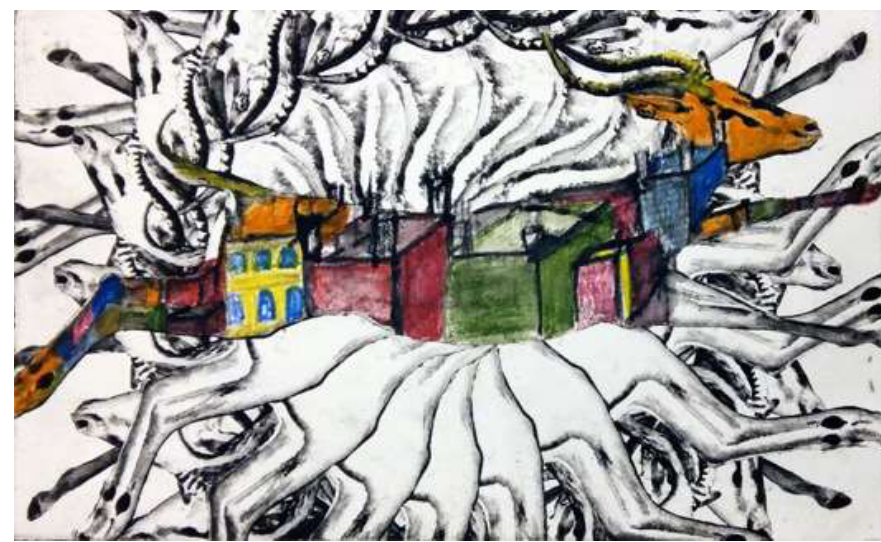
Figure 3. Manal Mahamid, A Village, Photo etching & pastel on archival paper, 35 × 26 cm, 2016, Edition 1 of 4.